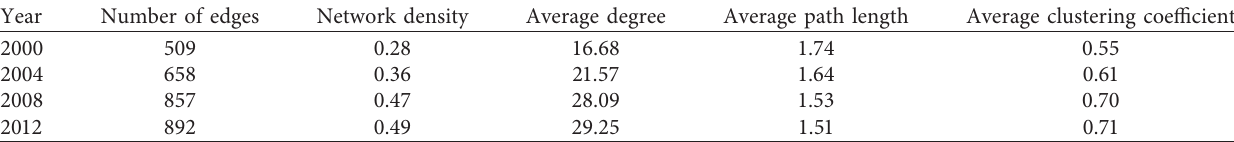
Table 3: Characteristic statistics of the overall network of producer services